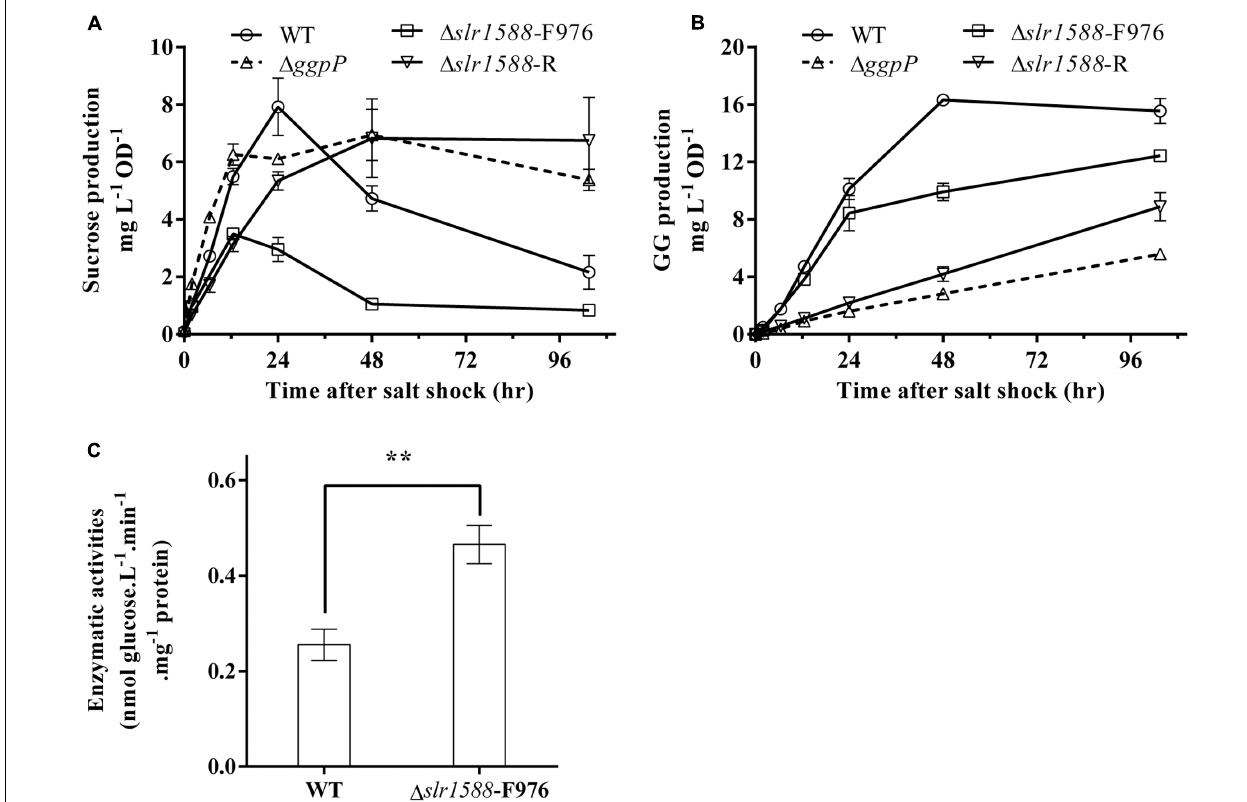
FIGURE 4 | Effects of the slr1588 inactivation on osmolyte contents and invertase. Cultures at late exponential phase of different strains were shifted to 4% of NaCl. Sucrose (A) and glucosylglycerol (GG) (B) contents were measured. (C) The invertase activity in the (cid:49) slr1588 -F976 was compared with that of WT in cells grown at 4% NaCl for 24 h. ∗∗ Stars represent significant differences ( p < 0.05) of enzymatic activities between the wild type (WT) and the (cid:49) slr1588 -F976 mutant